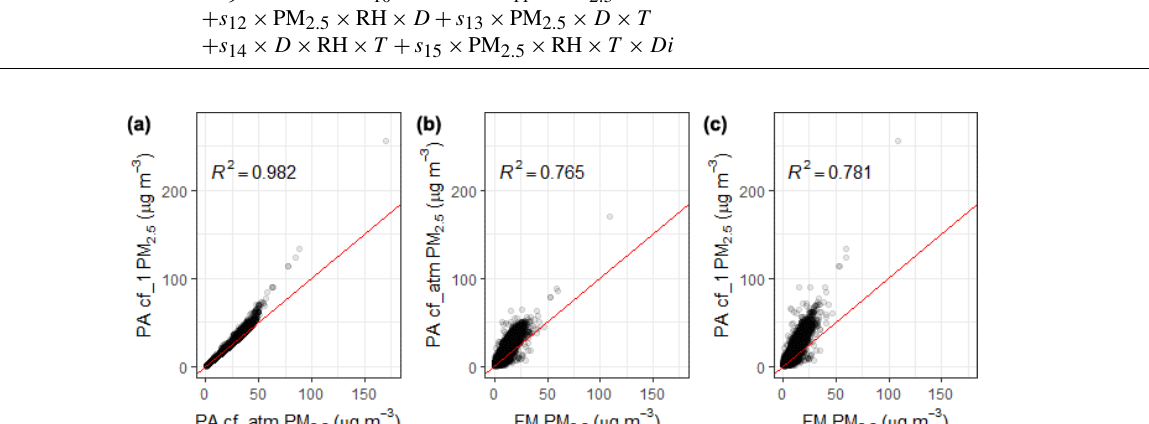
Figure 3. Comparison of the 24h raw PurpleAir (PA) cf_1 and cf_atm PM 2 . 5 outputs (a) and both outputs compared to the FEM or FRM PM 2 . 5 measurements (b, c) across all sites, with the 1:1 line in red.